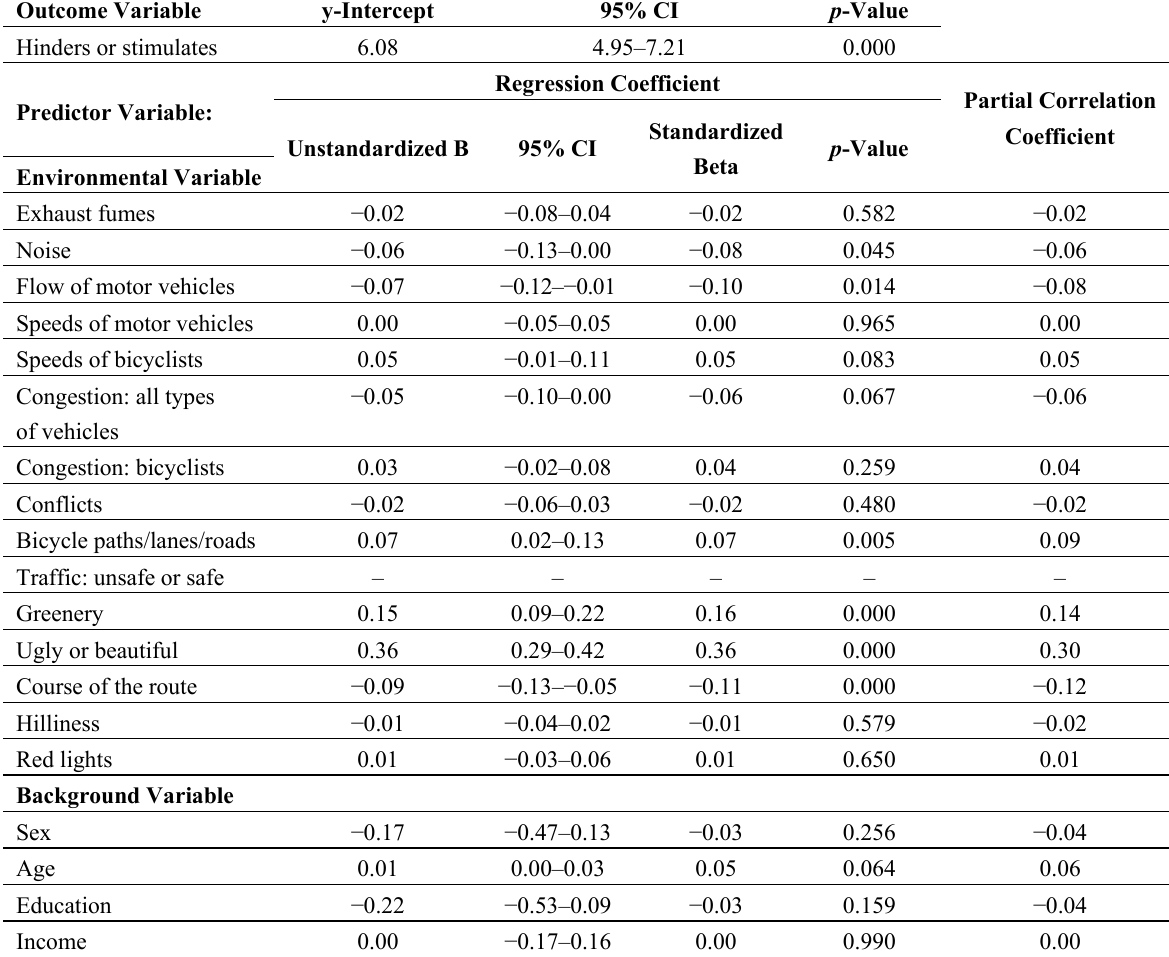
Table 5. Model 1, in which the item traffic: unsafe or safe was excluded: Simultaneous multiple regression analysis of route environment and background variables (n =